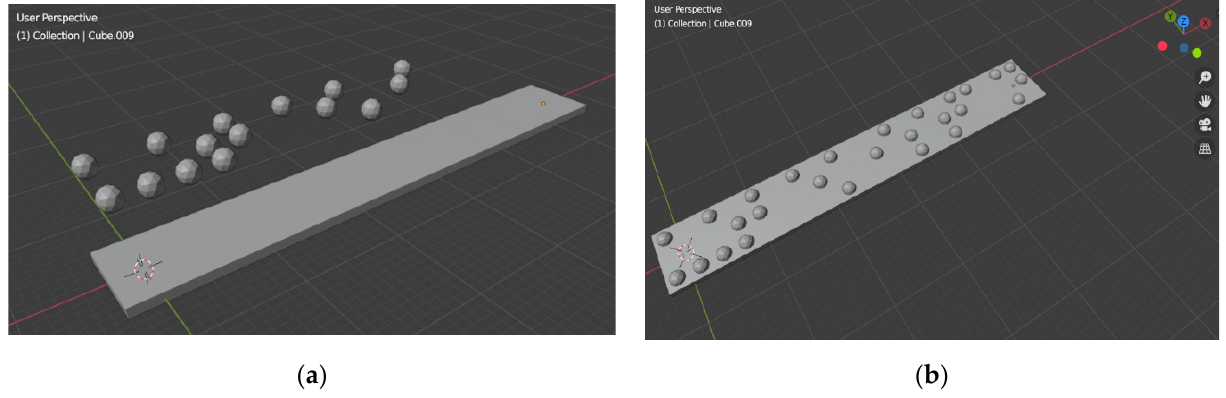
Figure 8. Preview of text preparation in Blender—Stage B: ( a ) creating inscriptions in Braille; ( b ) modelling tiles with text in Braille (the text in Polish—Uzbekistan, in ang. Uzbekistan).